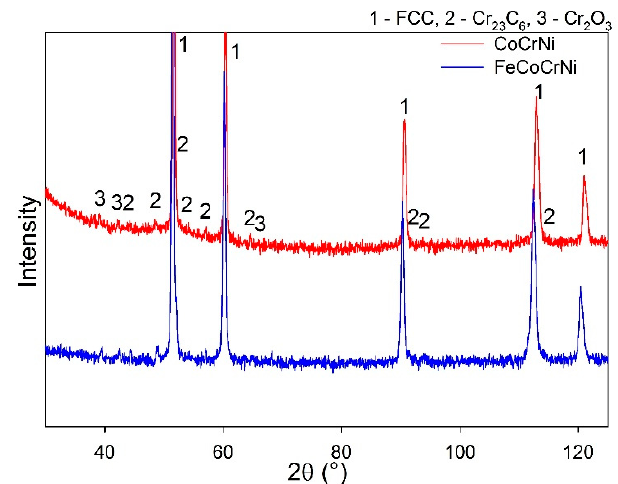
Figure 7. Phase analysis on the CoCrNi and FeCoCrNi alloys after 150 h oxidation at 950 °C. The analysis was performed in the area below the oxide scale outside the decarburized region.